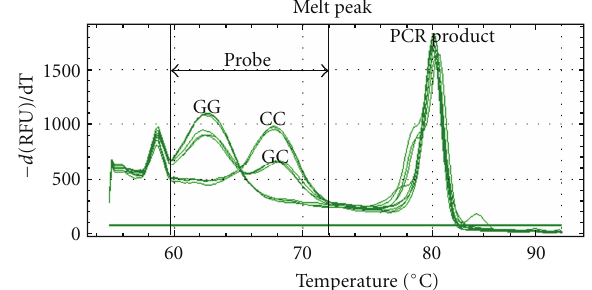
Figure 1: Derivative melting curves of unlabeled probes and amplicon for genotyping of SNP rs6887695. Three genotypes (GG, GC and CC) were discriminated as indicated in probe